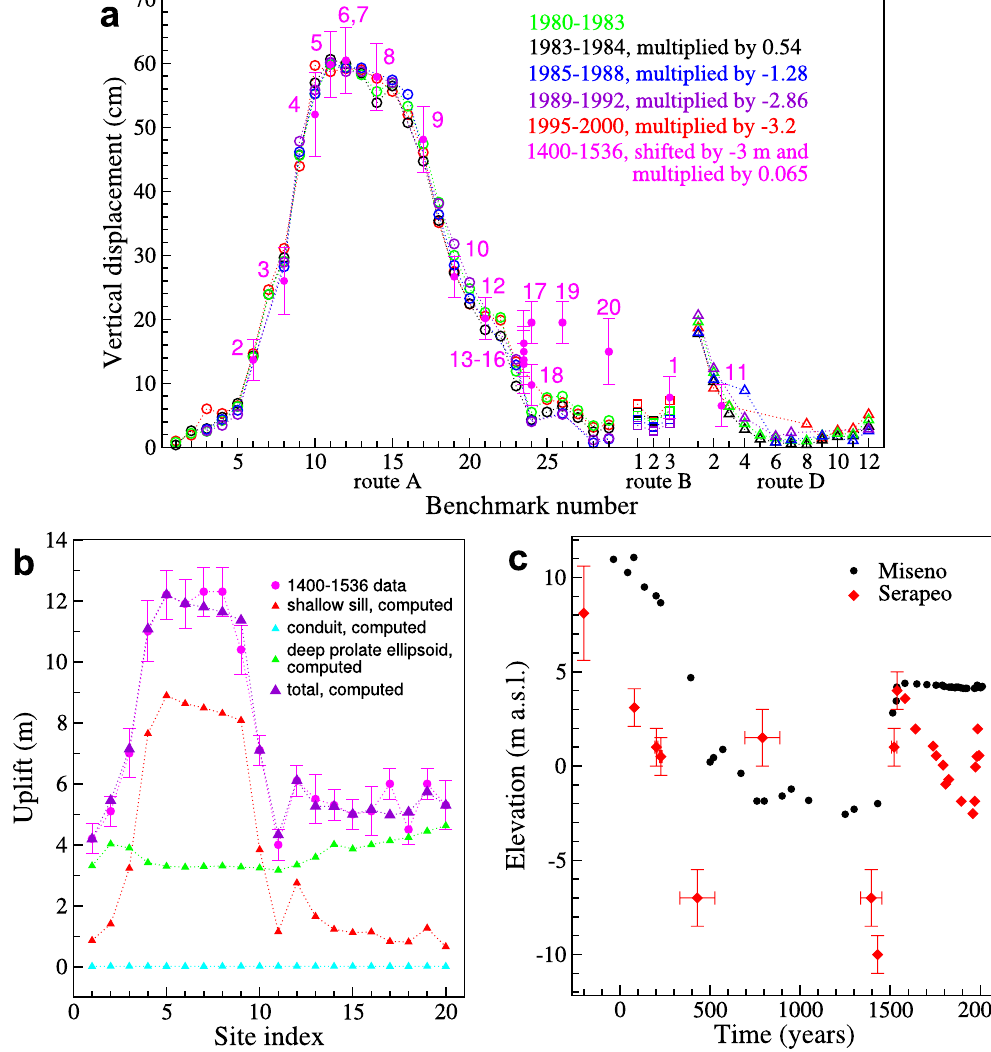
Figure 2. Vertical displacements in the last 2 ka. ( a ) Uplifts for different time periods along levelling benchmarks (symbols as in Fig. 1); magenta dots, 1400–1536 vertical displacement data and error bars 11 after subtracting a uniform 3 m upheaval. ( b ) Comparisons between 1400–1536 data and computations; site indexes as annotations in Fig. 1 and ( a ). ( c ) Deformation in the caldera centre (red diamonds, Serapeo) against caldera rim (black circles, Miseno) 47